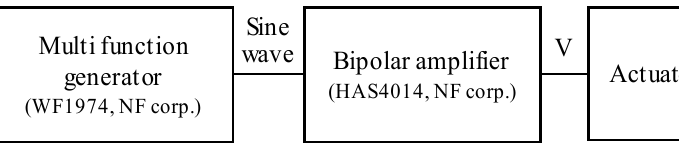
Figure 18. Input voltage for the frequency characteristics. Sensors 2020 , 20 , x FOR PEER REVIEW